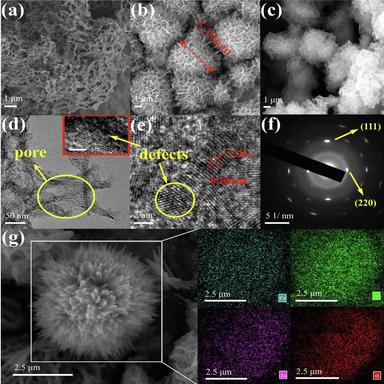
(a), (b) and (c) SEM images of flower-like ZCSd-6h, ZCSd-9h and ZCSd-12h microspheres grown on Ni foam, respectively; (d) TEM image of ZCSd-9h microspheres; (e) HRTEM image of ZCSd-9h microspheres; (f) SAED pattern of ZCSd-9h microspheres; (g) SEM image and transmission mapping images of ZCSd-9h.